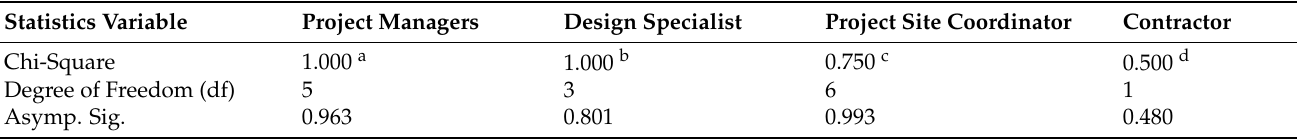
Table 5. Chi-Square test analysis on the extent of opinion consistency on Industry 4.0